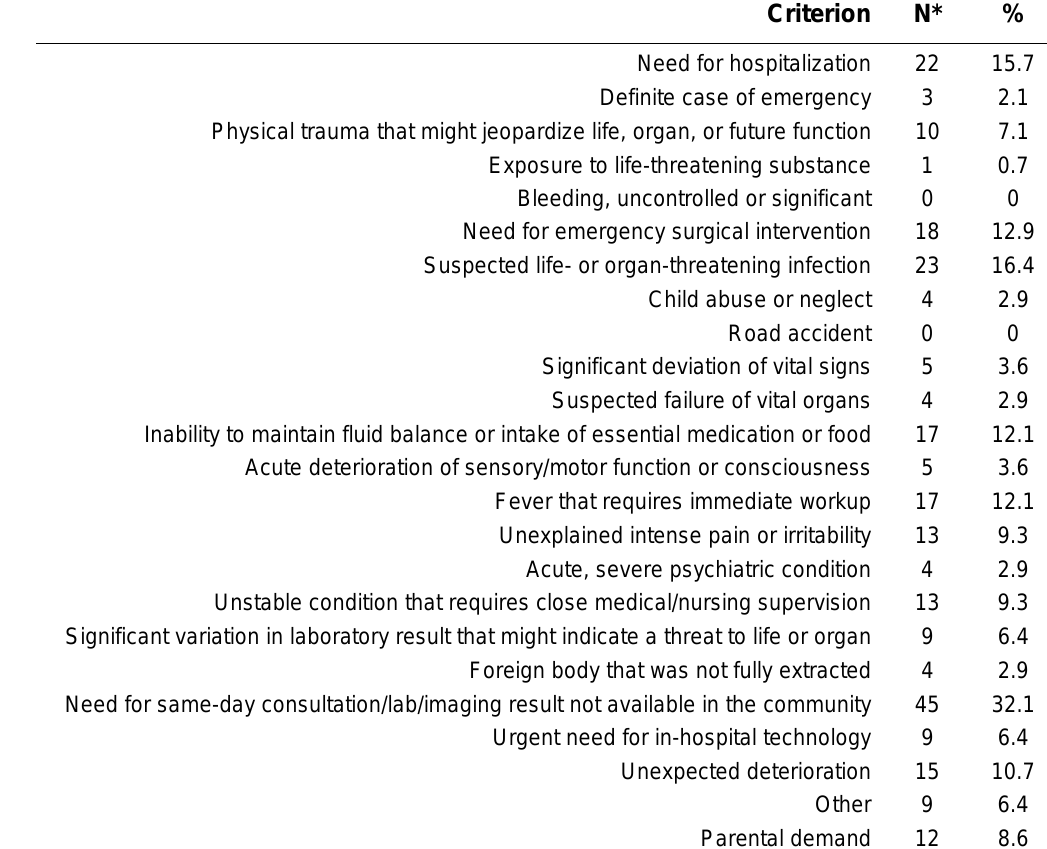
Frequency of Criteria for Referring Children to the